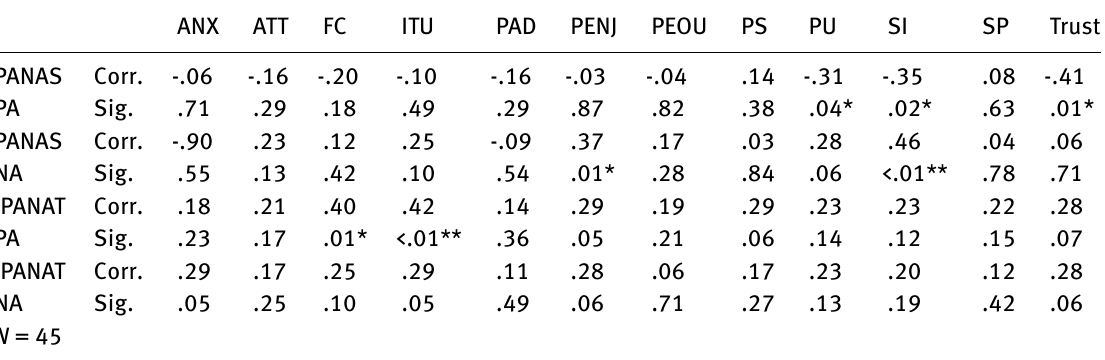
Table 3: Significant Correlations Between User Mood and Robot Acceptance. ANX ATT FC ITU PAD Trust PANAS PANAS iPANAT iPANAT Corr. NA Sig. .05 .25 .06 N =